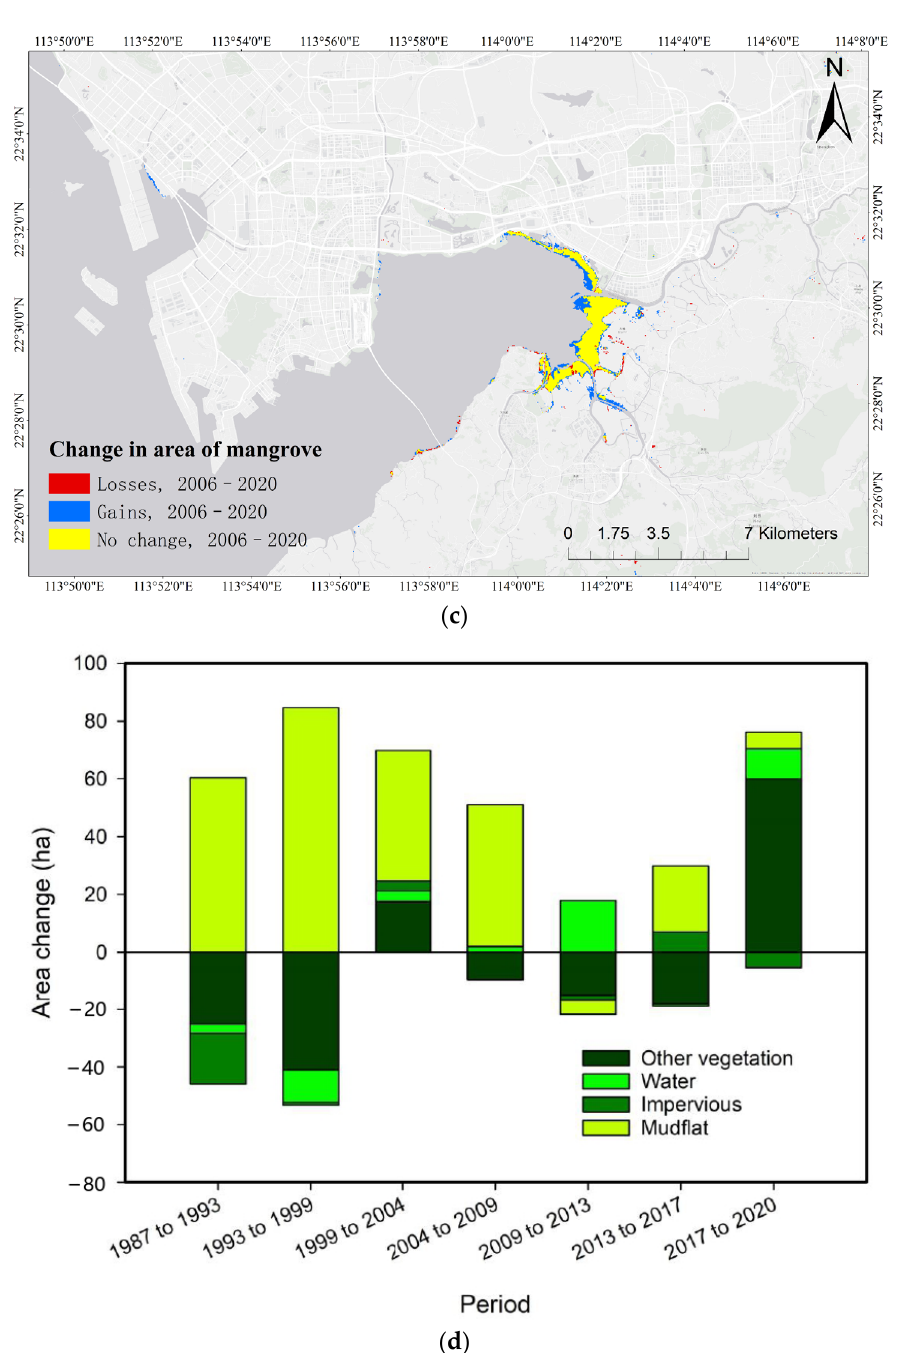
Figure 7. Mangrove habitats and other land cover types in Deep Bay between 1987 and 2020. ( a – c ), Change detection maps; and ( d ) Change detection statistics of mangrove habitats and other land cover types.